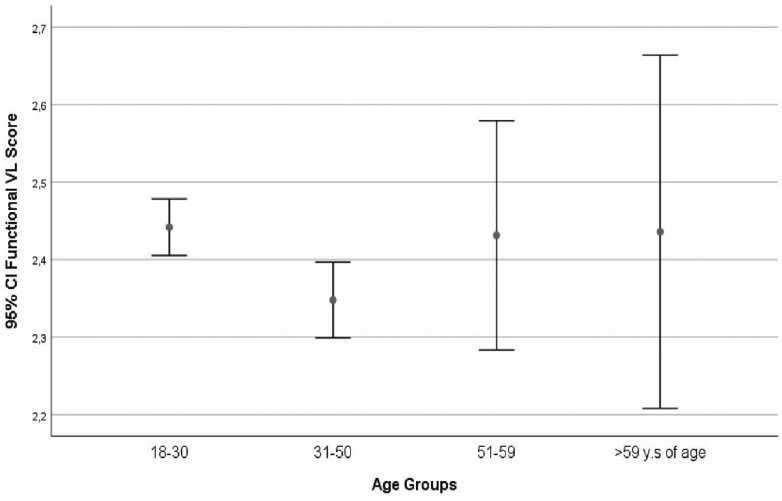
Figure 2. Observed functional Vaccines Literacy (VL) scores, visualized as mean and 95% CI (error bars), according to age